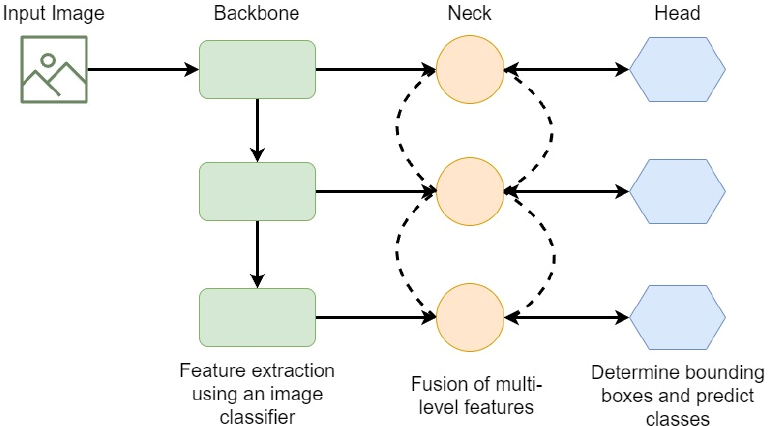
Figure 1. Backbone, neck, and head modules of a modern object detector. The backbone module utilizes a robust image classifier to extract features from an input image’s multiple resolutions and the neck, which is linked to the backbone, acts like a feature aggregator to fuse features of multiple resolutions. The head module then determines bounding boxes and predicts classes.